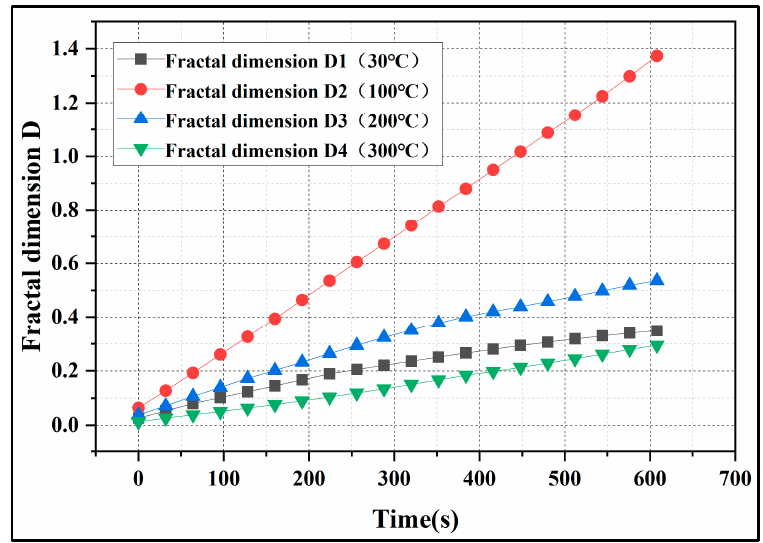
Figure 11. Fractal dimension change of AE counts at different temperatures. The fitted slopes of the different fractal dimension change curves were 0.999, 0.987, 0.981, and 0.998, respectively. According to the fractal dimension change chart of the AE